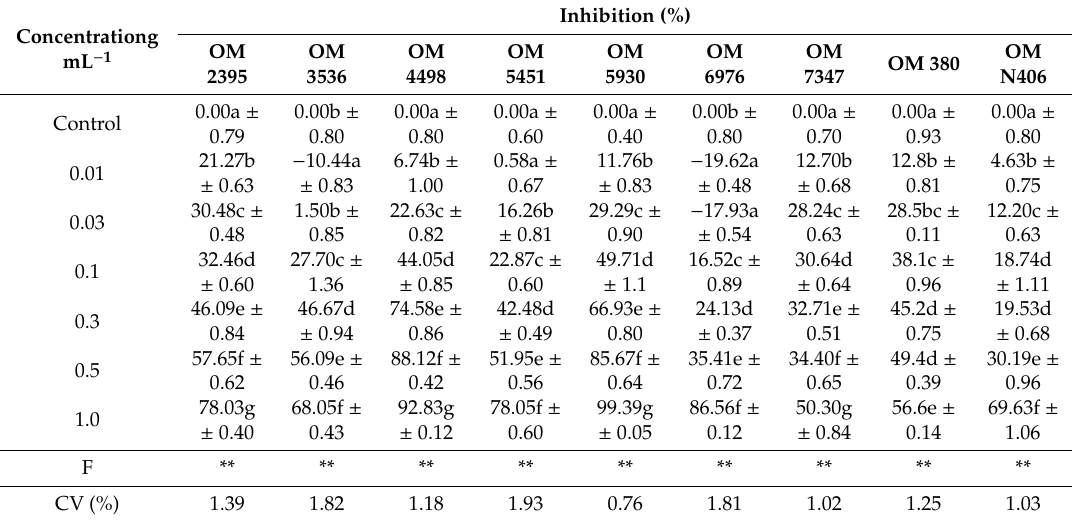
Table 2. E ff ect of MeOH extracts from nine OM rice cultivars on the growth of barnyardgrass root. Concentrationg mL −